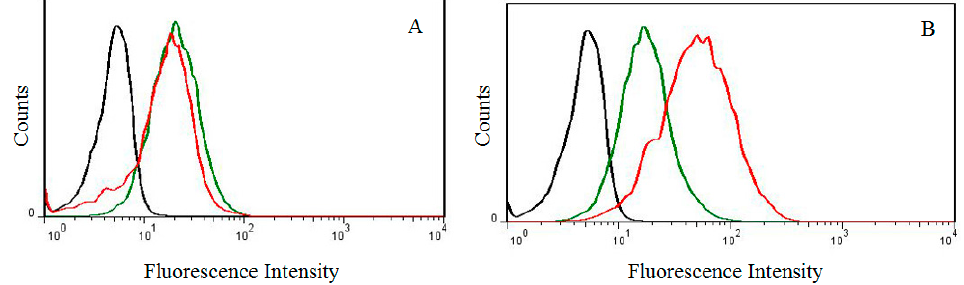
Figure 8. Cellular uptake of DNA/PEI (1/1) ( A ) and DNA/PEI/PPSD (1/1/32); ( B ) at different pH values in HeLa cells (gray, control; red, pH 7.4; green, pH 6.8) (All complexing ratios are expressed as weight ratios).